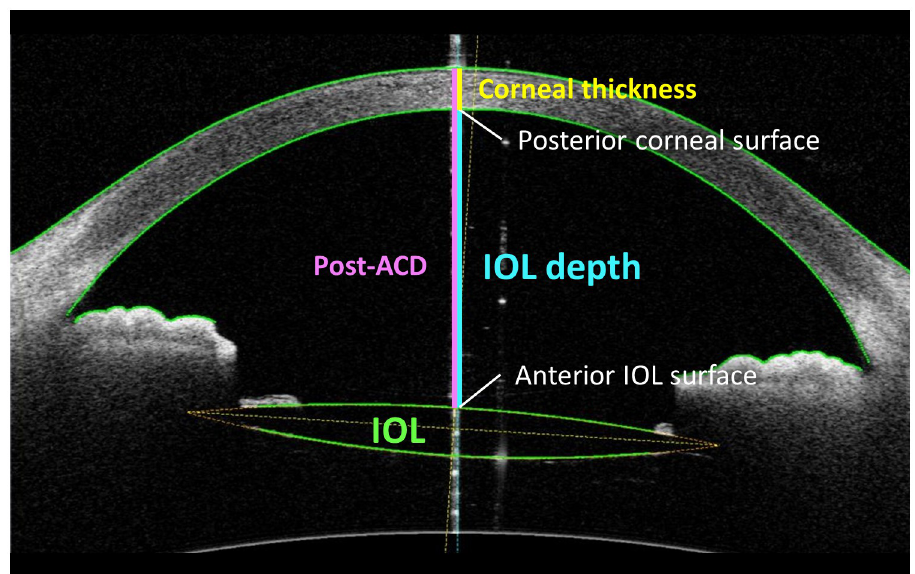
Fig 2. IOL depth measured using anterior-segment optical coherence tomography. IOL, intraocular lens, Post- ACD; postoperative anterior chamber depth.